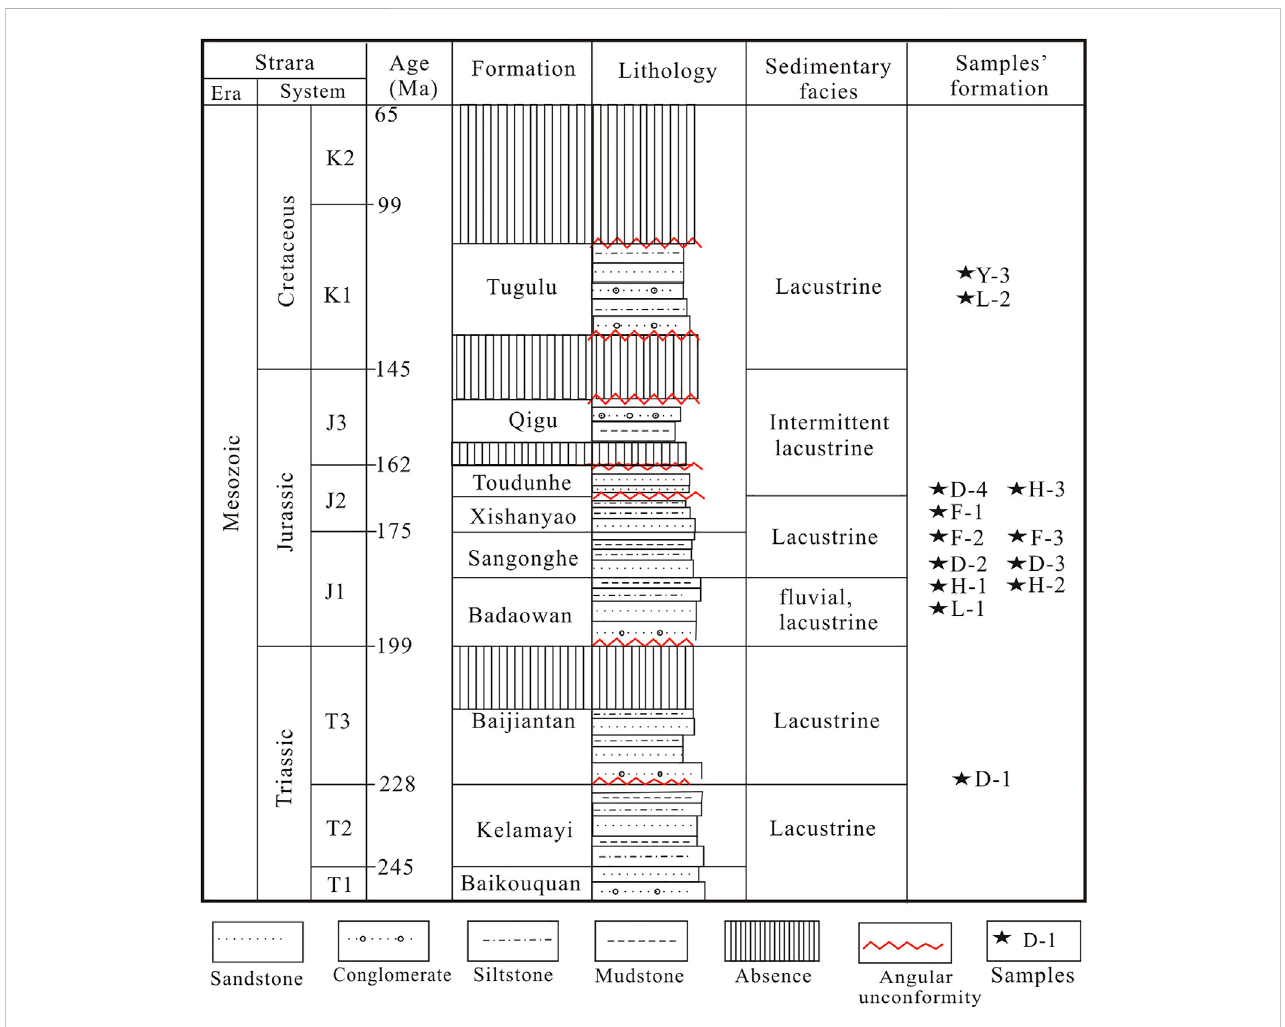
FIGURE 2 Generalized stratigraphic column of the Northern Junggar Basin showing sample locations, lithology and depositional facies.